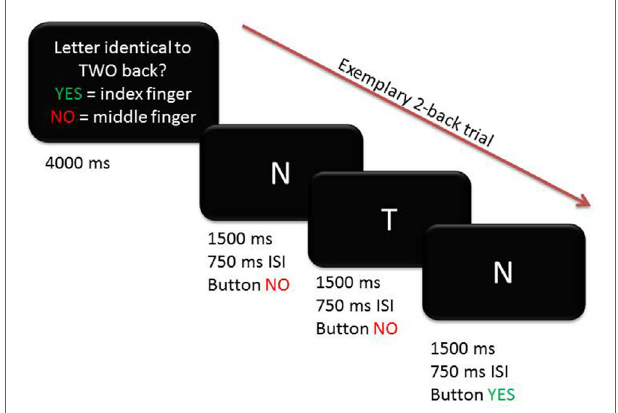
FigUre 1 | Exemplary trial for 2-back condition depicting timing and correct button presses.